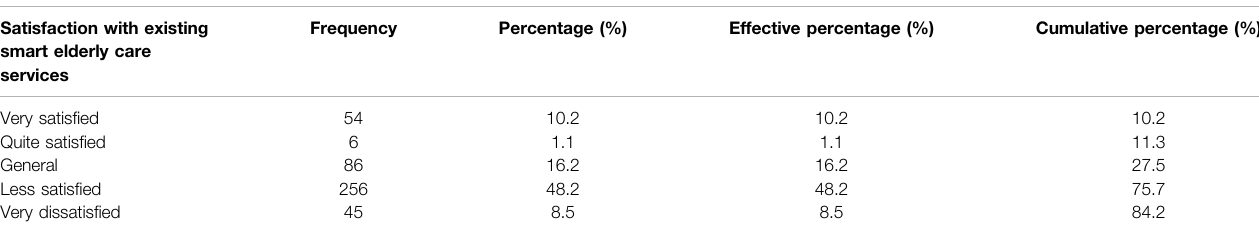
TABLE 3 | Satisfaction with smart elderly care services. Satisfaction with existing smart elderly